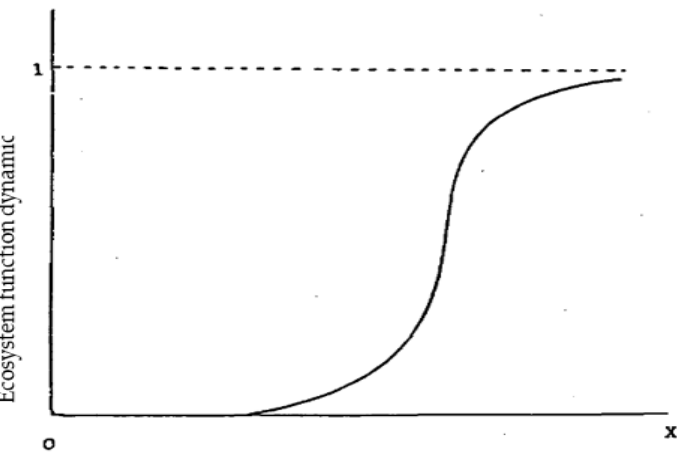
Figure 3. A sigmoid curve of Lake Malombe ecosystem function dynamics.